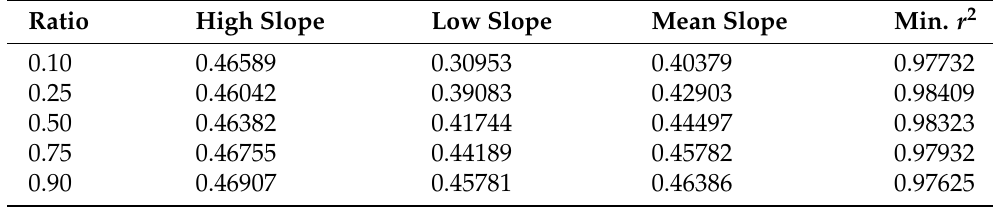
Table 3. Linear fit results for Figure 9.